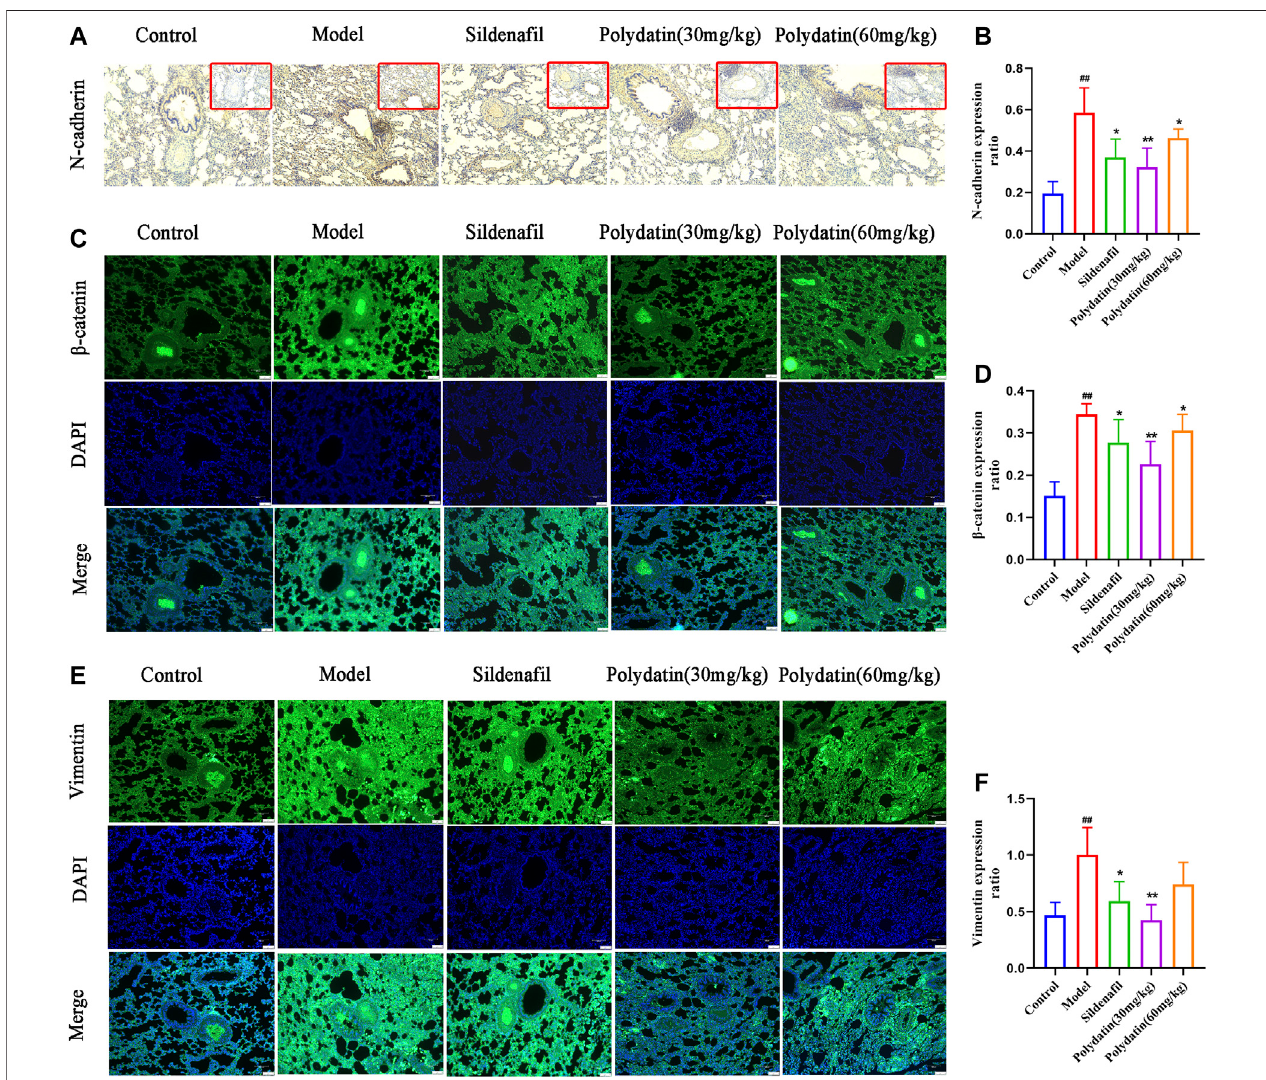
FIGURE 5 | Polydatin improves lung endothelial cell dysfunction induced by MCT. (A – B) Representative immunohistochemical staining (100 × magni fi cation) and gray mean valuesofN-cadherinexpression inlungtissues. (C – D) Representative immuno fl uorescence staining(100 ×magni fi cation) and gray meanvalues of β -catenin expression in lung tissues. (E – F) Representative immuno fl uorescence staining (100 × magni fi cation) and gray mean values of vimentin expression in lung tissues. Data correspondtomean values±standarderror. Groups werecomparedusing One-wayANOVA adjustedwith Dunnett ’ s test. * p < 0.05and ** p < 0.01versuscontrol group. # p < 0.05 and ## p < 0.01 versus model